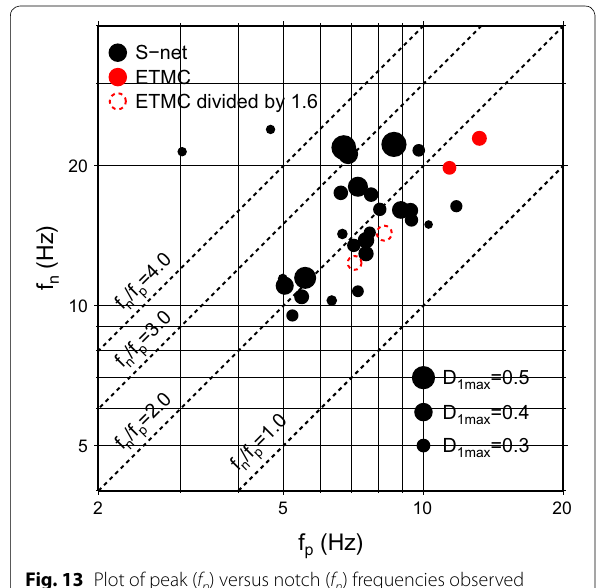
Fig. 13 Plot of peak ( f p ) versus notch ( f n ) frequencies observed for S-net (black circles) and ETMC (red circles) stations with D 1max > 1.5 D 2max . The dotted red circles are the peak and notch frequencies of ETMC stations divided by